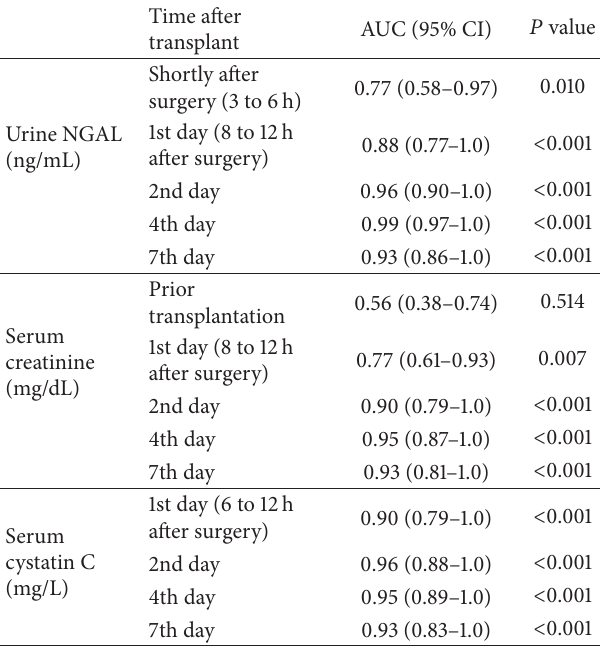
Table 5: Area under the receiver-operating characteristic curve at each time point for uNGAL, serum creatinine, and serum cystatin C for predicting DGF.